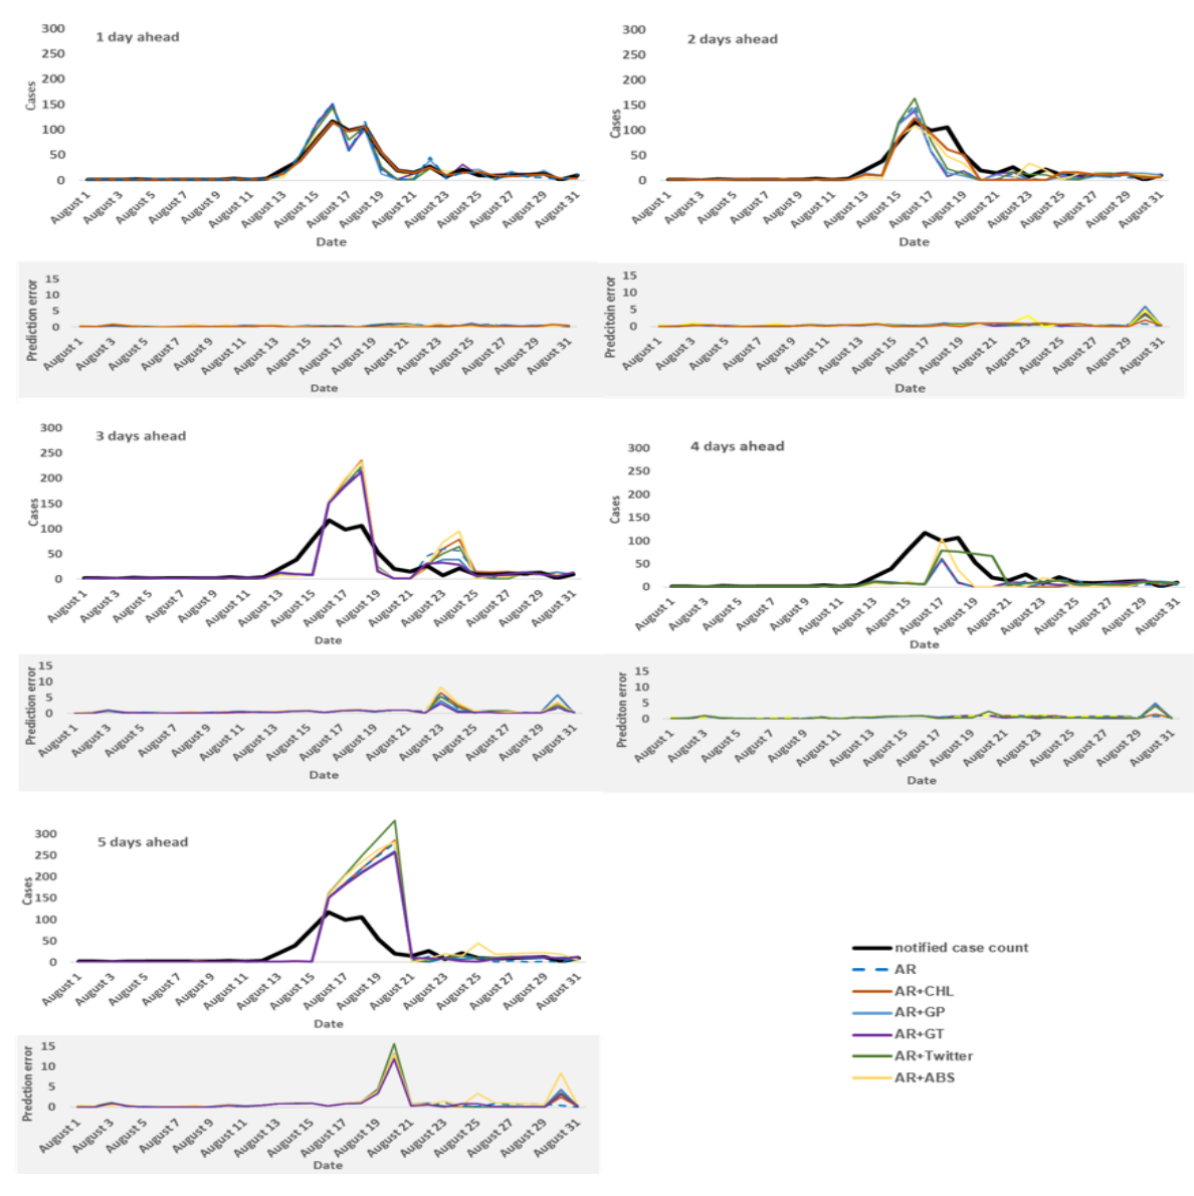
Table 4 summarizes the predictive performance of the models during the test period for each of the 1-, 2-, 3-, 4-, and 5-day ahead predictions, as captured by the 3 evaluation metrics RMSE, rRMSE, and ρ . Although some model’s predictions showed good correlation with the notified case counts, their predictions showed large discrepancies from the true number